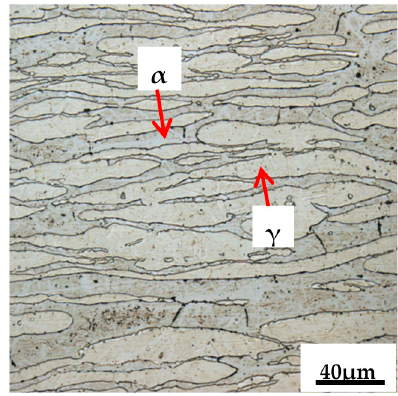
Figure 1. Optical microstructure of 2707 hyper duplex stainless steel (HDSS) after reheating.